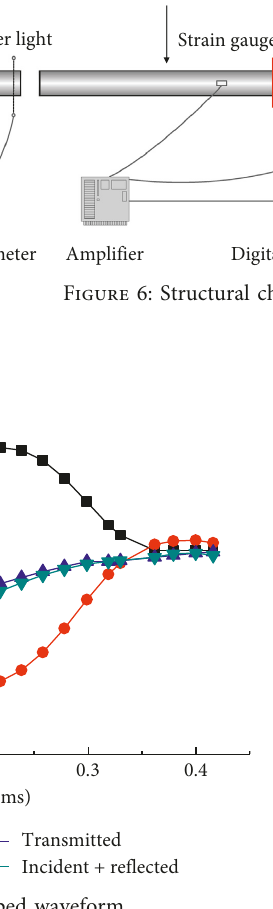
Figure 7: Typical shaped waveform.